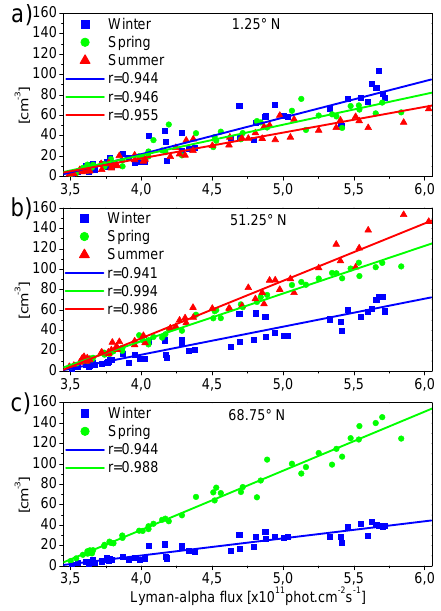
Figure 5. Dependence of the concentration of OH ∗ Lyman- α flux in low (a) , middle (b) , and high (c) northern latitudes for winter (blue lines), spring (green lines), and summer (red